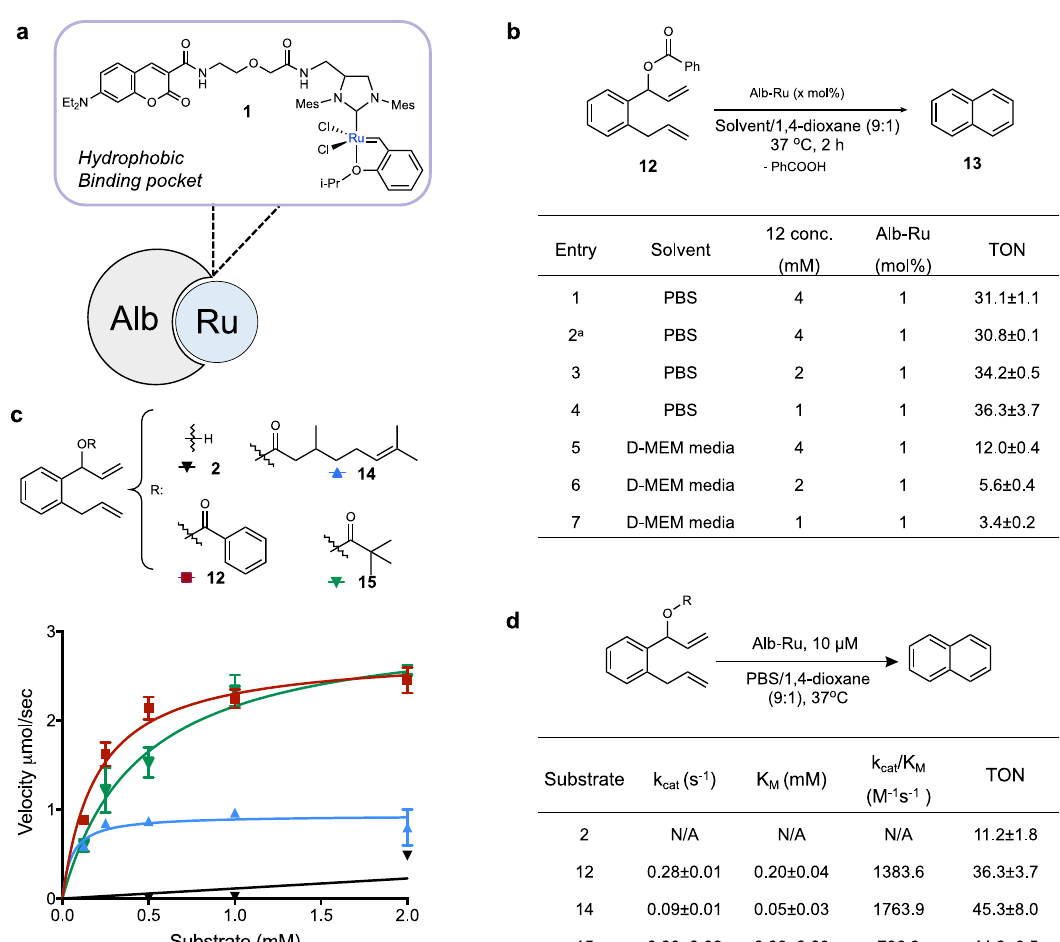
Fig. 3 ArM-based activity studies with naphthalene-based precursors. a The anchoring of 1 into the hydrophobic binding pocket of albumin (Alb) leads to the creation of Alb-Ru, which is capable of performing ring-closing metathesis. b Reactivity studies focused on the RCM activity of precursor 12 under various substrate concentrations and solvents. a 20 mol% of glutathione added. Reactions were performed in triplicate; TON values were determined from product yields obtained by HPLC analysis. Michaelis – Menten kinetic graphs c and parameters d for substrates ( 2, 12, 14, 15 ). Summarized values are the substrate af fi nity (K M ), turnover frequency ( k cat ), and catalytic ef fi ciency ( k cat /K M ). Also presented are the TON Arom using 1 mM substrate concentrations, which were incubated with 1 mol% of Alb-Ru in PBS/1,4-dioxane (9:1) for 2 h at 37 °C. Reactions were performed in triplicate. Data in c are represented as mean values ± SD, n = 3 independent